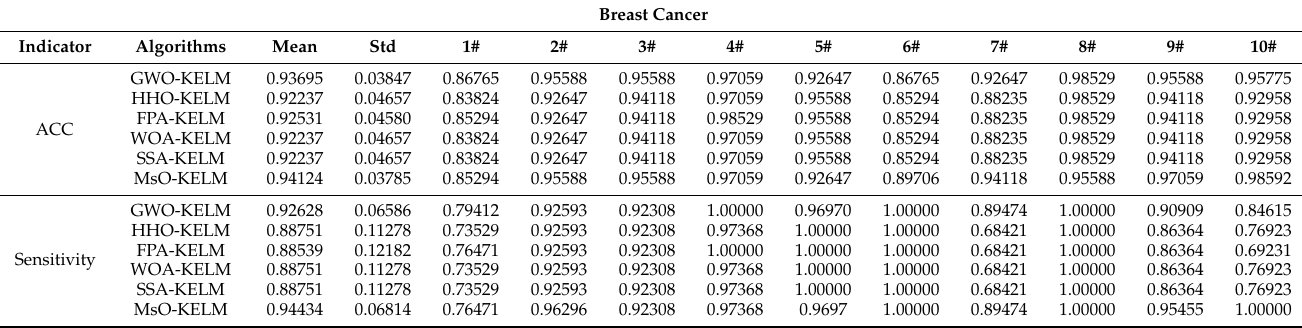
Table 6. The prediction results on disease dataset Breast Cancer. Breast